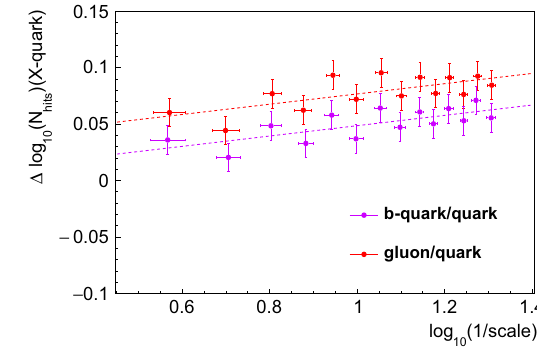
between quarks, b-quarks and gluons are predicted to be energy inde- pendent [31]. The small but non-zero slopes in this plot reflect the fact that box-counting at a given angular scale probes spatial information in addition to the rate of splitting at the corresponding energy